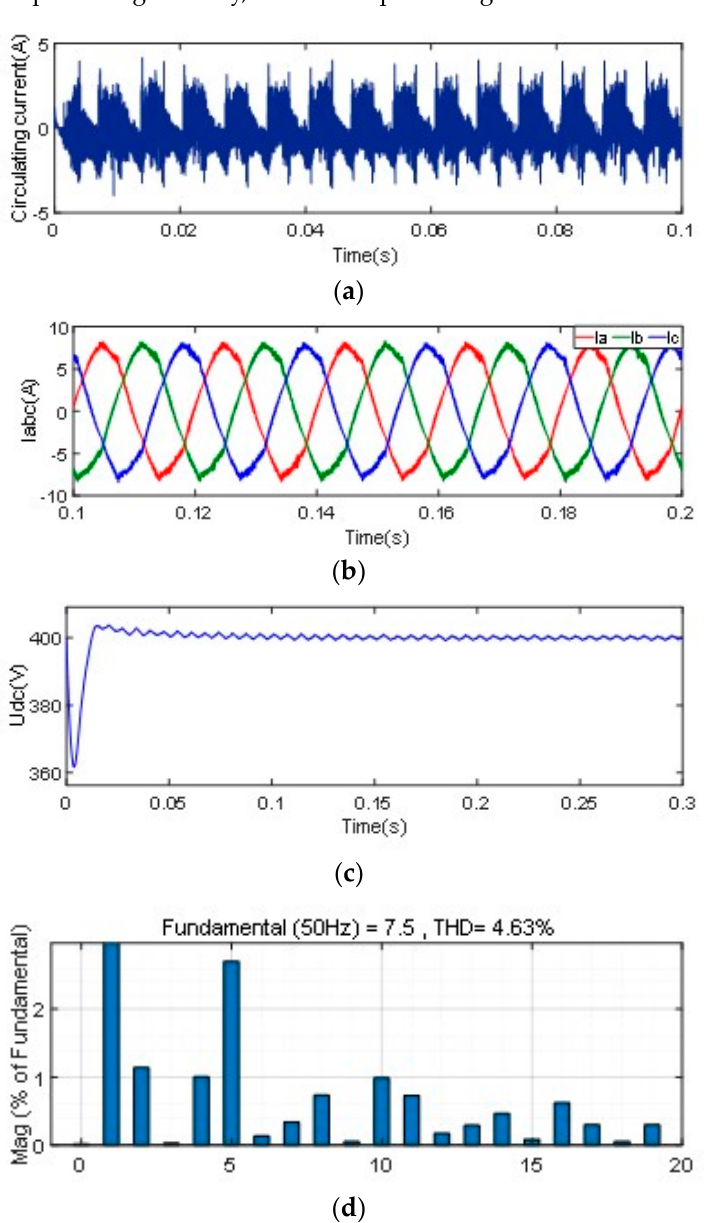
Figure 9. The control scheme for suppressing circulating current is not added under different DC-side inductance parameters ( a ) Positive DC bus circulating current. ( b ) AC side current. ( c ) DC side output voltage. ( d ) THD of AC side current.